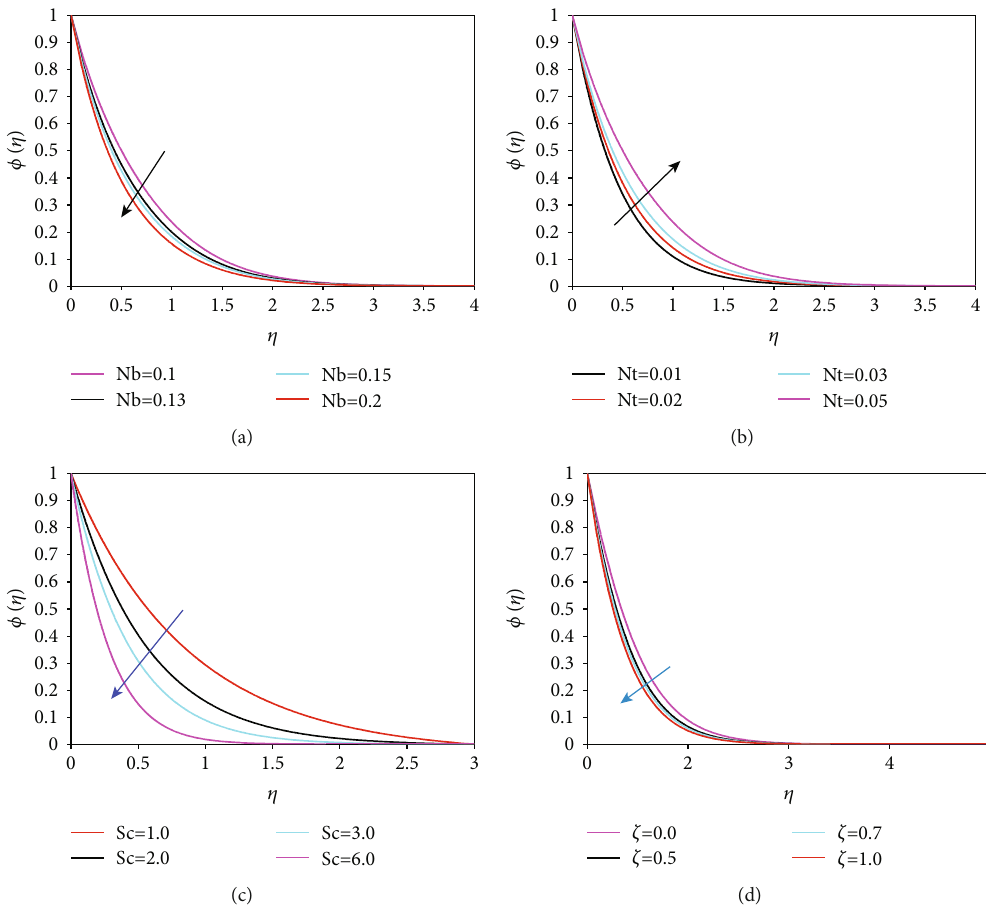
Figure 15: The graph of concentration for di ff erent values of Brownian motion (Nb), thermophoresis parameter (Nt), Schmidt number ð Sc Þ , and temperature di ff erence parameter ( ζ ); the velocity declines with an increase of the magnetic fi eld parameter. From (b, c), it can be seen that the temperature and concentration upsurge with an increase of the magnetic fi eld parameter ( M ). The physical meaning of this behavior is an upsurge in the values of the magnetic fi eld parameter develops the force opposite to the fl ow, which is known as Lorentz force. This body force reduced the boundary layer fl ow and congeals the velocity boundary layers. Furthermore, this force creates a resistance force that opposes the fl uid motion. Therefore, for the higher magnetic fi eld, heat is generated leading to a boost in the temperature and thermal boundary layer thickness. Table 2: Comparison of values of the Nusselt number ð − θ ′ ð 0 ÞÞ and Table 1: Comparison of values of skin friction coe ffi cient ð f ″ ð 0 ÞÞ Sherwood number ð − ϕ ′ ð 0 ÞÞ for various values of Pr and E with for various values of λ with earlier scholar results. earlier scholar